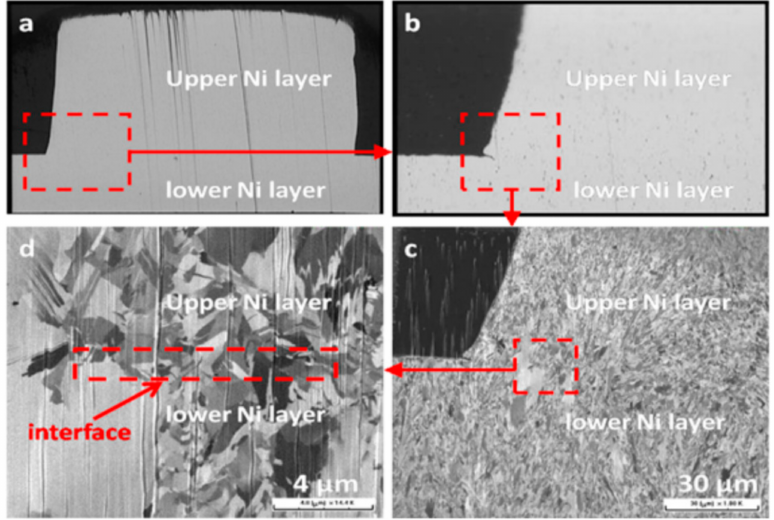
Figure 6. Different magnification cross-section morphology and microstructure of the Ni films treated by anodic